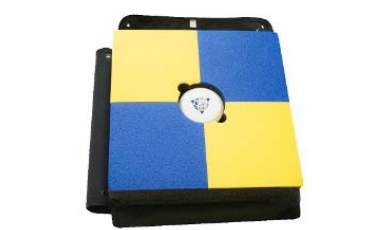
Figure 2: Trimble SmartTarget Base Station